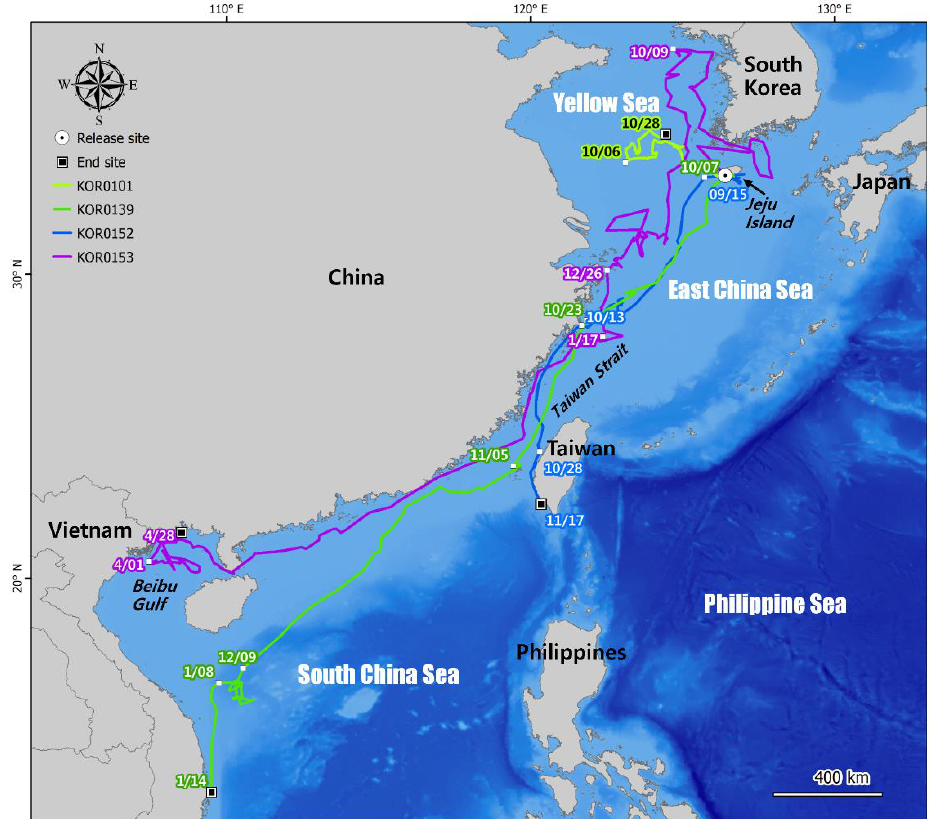
Figure 3. Travel routes of four satellite-tracked green turtles. KOR0101 with a CCL less than 40 cm stayed in the Yellow Sea, while three turtles with CCLs over 40 cm traveled to the southwest.